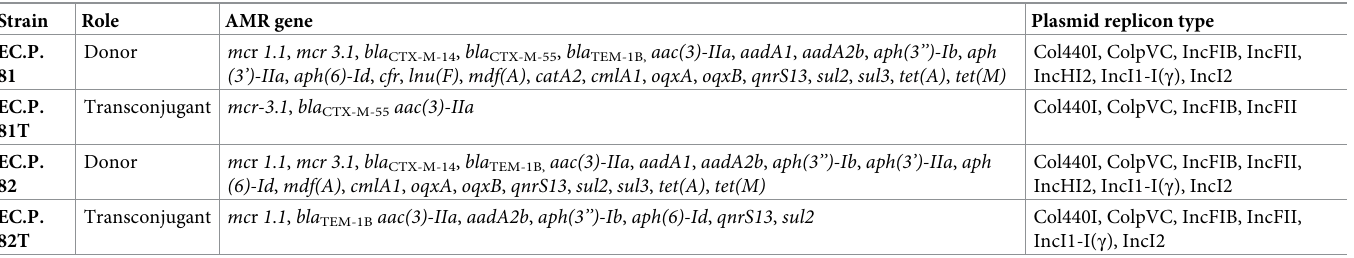
Table 3. Antimicrobial resistance genes and plasmid contents in donors and transconjugants revealed by